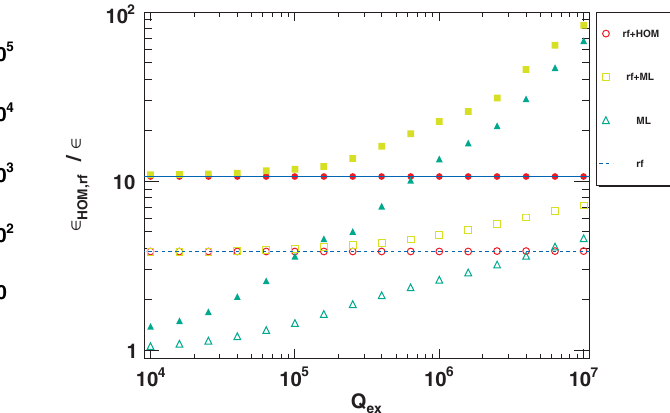
FIG. 19. Average (hollow dots) and maximum (filled dots) at nominal current phase space increase against the damping Q ex for different cases, where rf errors (rf) and/or a HOM at a machine (ML) or off resonance (HOM) is present. The average (dashed line) and maximum (solid line) increase due to pure rf errors is also included. Settings: uniform distributed rf errors i ¼ 40 mA , (0.5 (cid:8) in phase and 0.5% in magnitude), h I b i ¼ 1 ; 408 : 8 MHz , N ¼ 100 , see Table VI. h f HOM ; ML